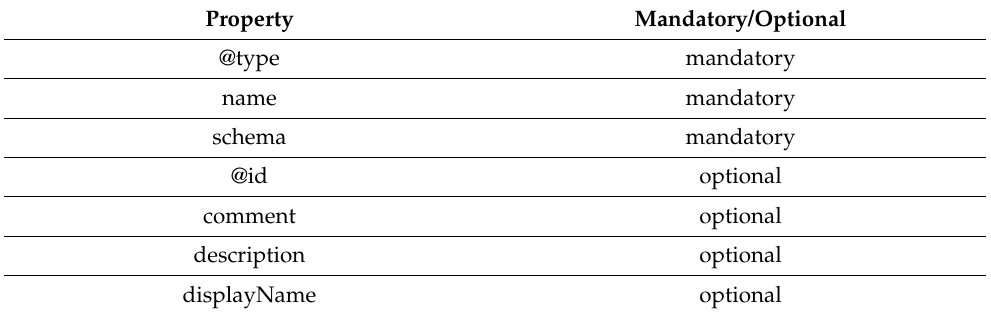
Table 13. Properties of the Component class.